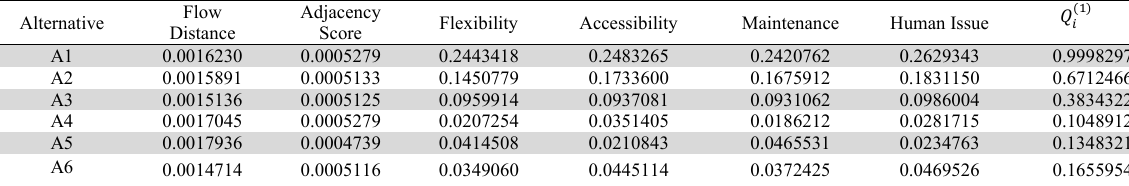
Weighted normalised decision matrix and performance score of WSM